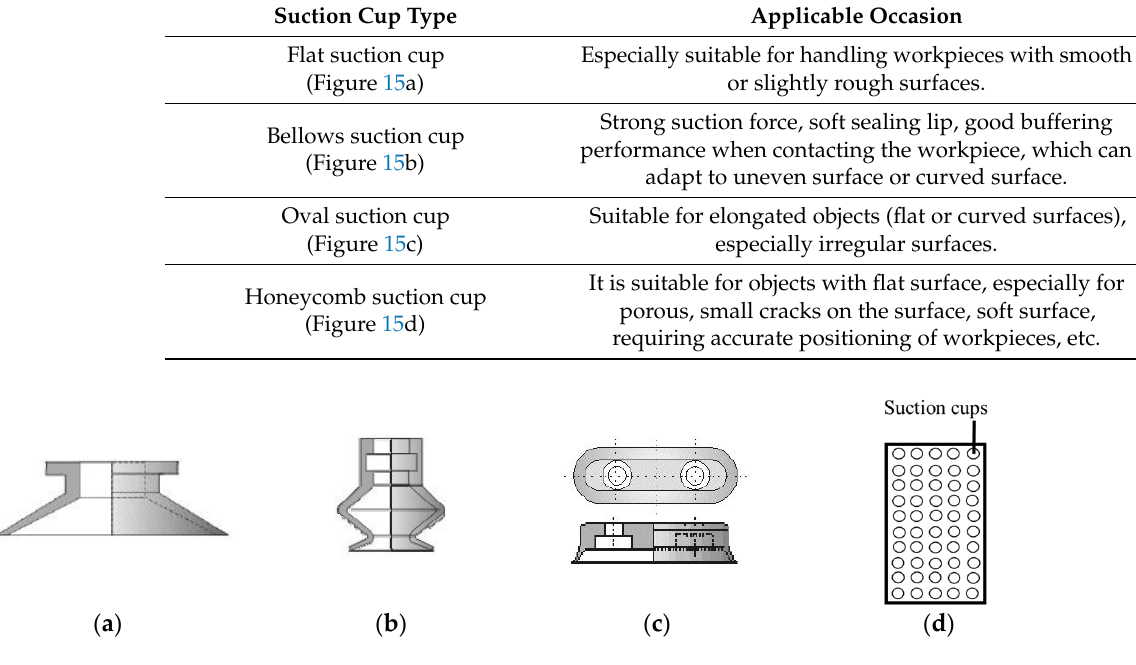
Figure 15. Suction cup type: ( a ) flat suction cup; ( b ) bellows suction cup; ( c ) oval suction cup; ( d ) honeycomb suction cup.